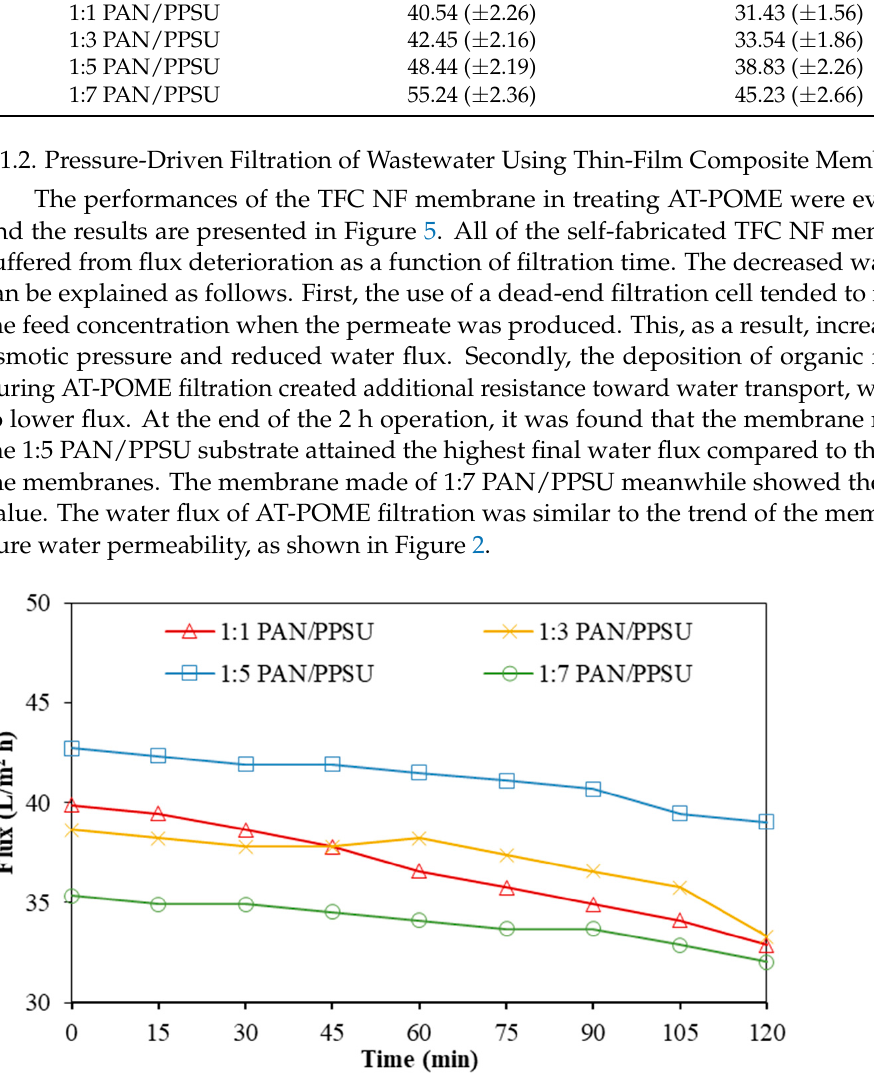
Figure 5. Water flux profile of TFC NF membranes made of different PAN/PPSU substrates as a function of filtration time. (Operation mode: pressurized filtration; feed solution: AT-POME; operating pressure: 10 bar; temperature: 24 °C (+1)).